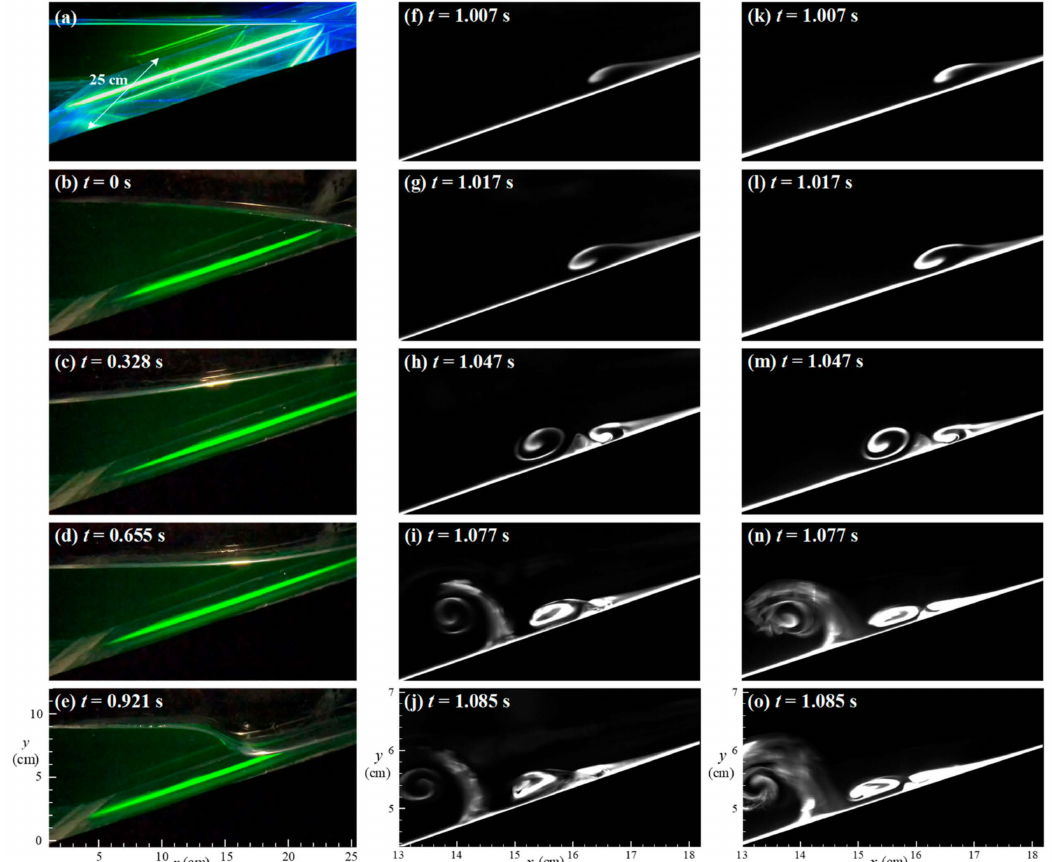
Figure 7. Flow visualized images: ( a ) Close-up of green dye strip (with nearly constant width) over beach surface, while water volume inside wave flume being kept quiescent; (b – e ) dye strip transported onshore without changing its width in spanwise direction at five different times; ( f – j ) flow structures on central vertical plane 12.5 cm away from front sidewall at five distinct times; ( k – o ) the counterparts each with same time as that shown in ( f – j ), respectively, and on vertical plane 8.0 cm away from front